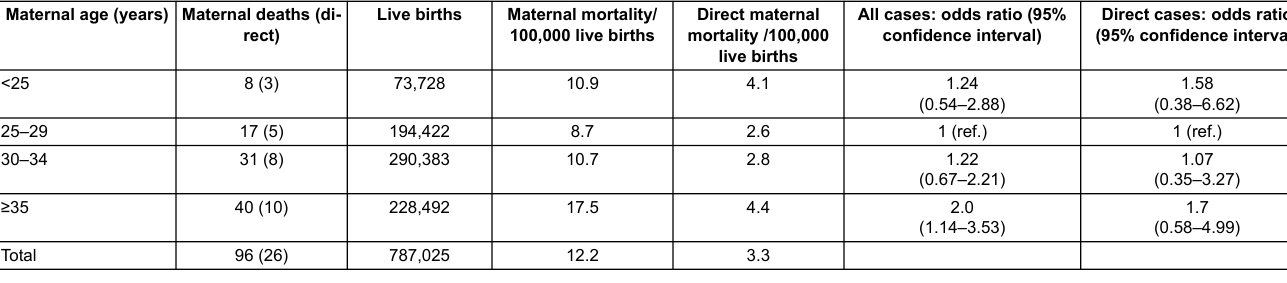
Table 5: Maternal mortality by maternal age in Switzerland 2005–2014. Maternal age (years) Maternal deaths (di-